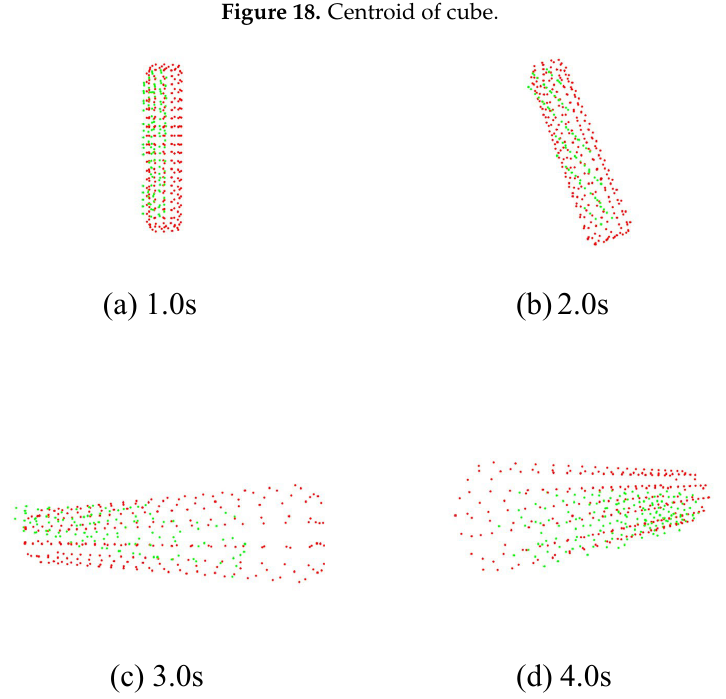
Figure 19. Point cloud data of cylinder.